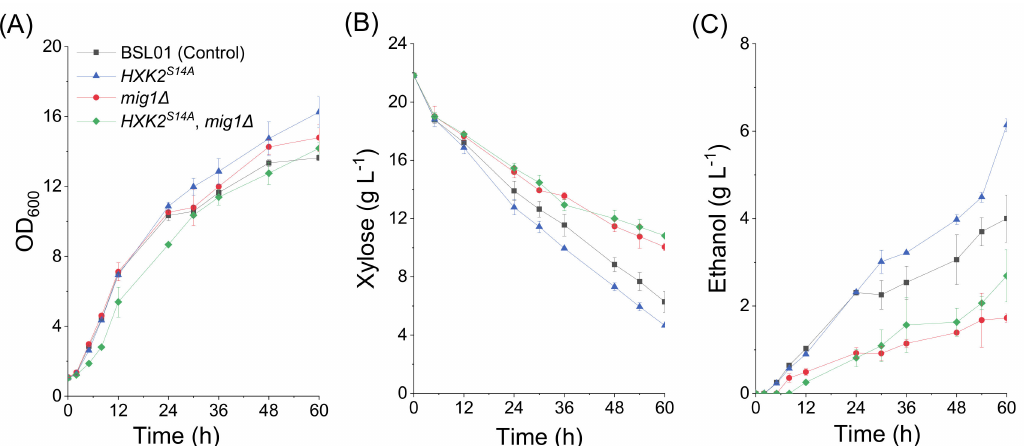
Figure 2. The fermentation characteristics of S. cerevisiae recombinant strains cultured in medium containing xylose as the sole carbon source. Fermentation was performed in shake flasks at 200 rpm 30°C with an initial OD 600 of 1 (biomass ≈ 0.23 g DCW L −1 ). All the data represent the mean value of triplicate tests. Symbols: ■ , BSL01 (control); ▲ , BSHA01 (BSL01 derivative; HXK2 S14A ); ●, BSHM01 (BSL01 derivative; mig1Δ ); ◆ BSHM02 (BSL01 derivative; HXK2 S14A ; mig1Δ ). Table 2. Xylose fermentation characteristics of the parental and engineered yeast